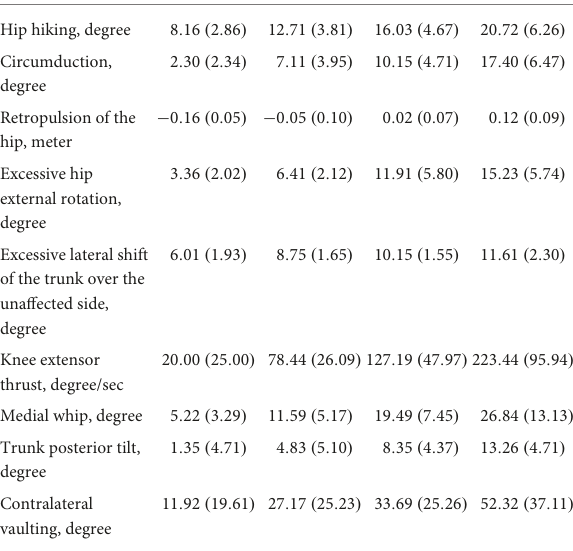
TABLE 3 Index values of abnormal gait patterns calculated by the gait analysis system using the Welwalk WW-2000.